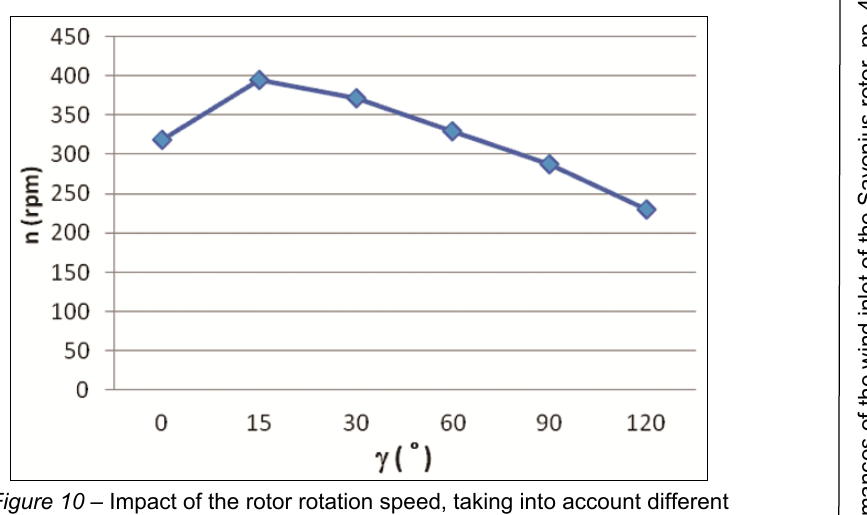
Figure 10 – Impact of the rotor rotation speed, taking into account different vertical angles of the wind inlet  Рис . 10 – Влияние скорости вращения ротора , с учетом разной